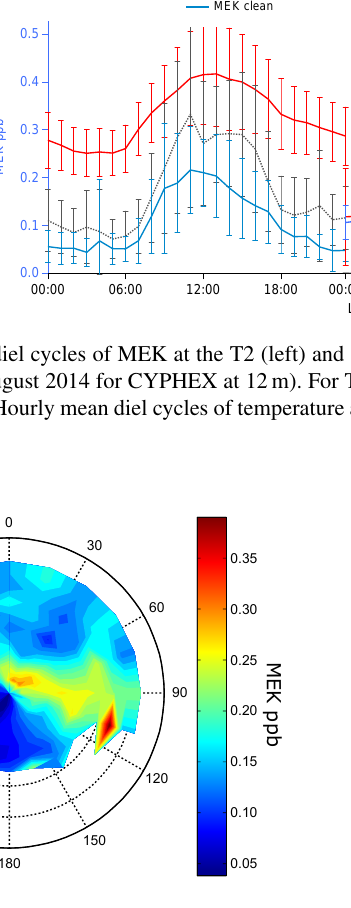
Figure 6. Polar surface plot for average MEK mixing ratios at a given wind direction (angle, 1–5ms − 1 ) and wind speed (radius).